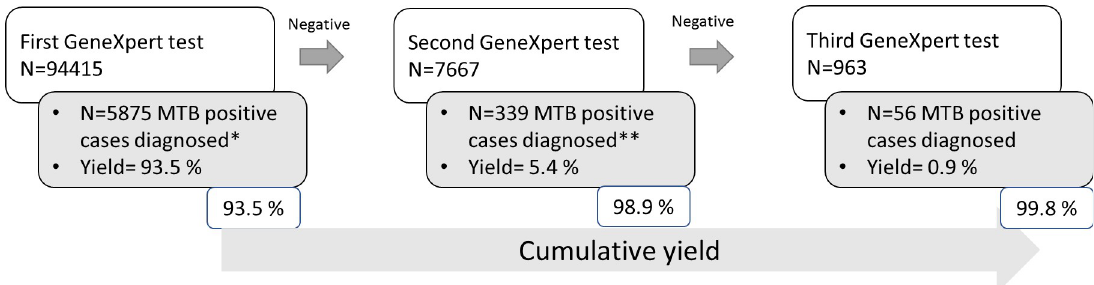
Fig 1. Incremental yields among first, second and third round Xpert MTB/RIF testing. � Cases diagnosed positive among those for whom the first Xpert MTB/RIF test did not show a positive MTB result but was suspected by the health care provider. �� Cases diagnosed positive among those for whom the first and second Xpert MTB/RIF tests did not show a positive MTB result but was suspected by the health care provider.